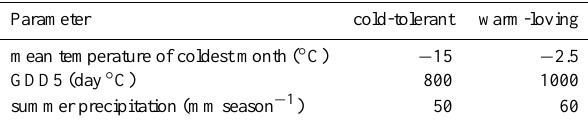
Table 3. Minimum requirements for summer-green tree growth from LA2007 and used in this